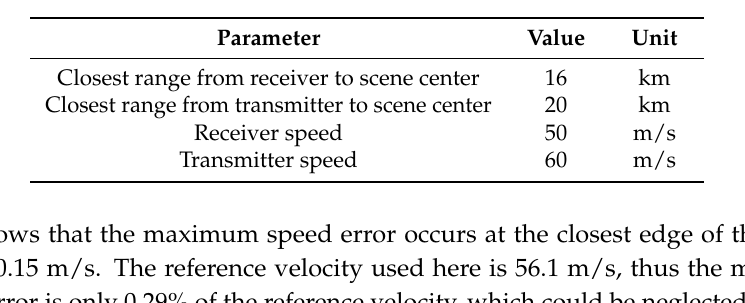
Table 2. Parameters for velocity error calculation.